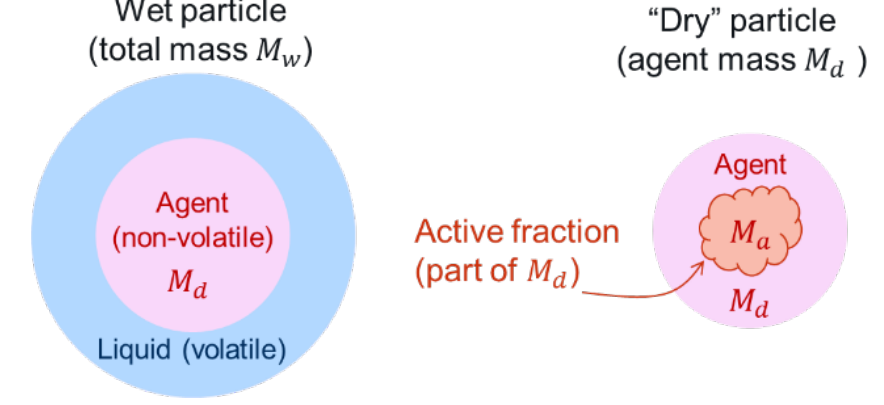
Figure A2. Simplified schematic of a particle. volatile components and 97% water by mass [71]. The nonvolatile components are varied, as shown in Table A1. Most of a saliva particle is made up of salts (NaCl and KCl) and mucin; these components will affect the dehydration and rehydration of particles and, for a high-fidelity model, should be tracked. For dehydration, we used data from [48] and consultation with Walker to determine post-evaporation diameters from pre-evaporation diameters. We settled on a post-evaporation diameter of 29% of the original pre-evaporation saliva particle